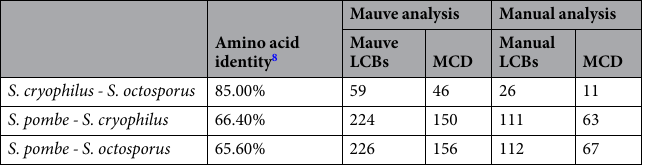
Table 3. Comparison of sequence and structural evolution of the fission yeasts. The results suggested that structural differences might correlate (Pearson’s r = 0.99; P = 0.0176) with the established amino acid divergence (1-identity). Values of amino acid identity originated from 8 . Mauve LCBs: locally collinear blocks (conserved regions of the chromosomes) established by Mauve 49 . Manual LCBs: manually selected LCBs larger than